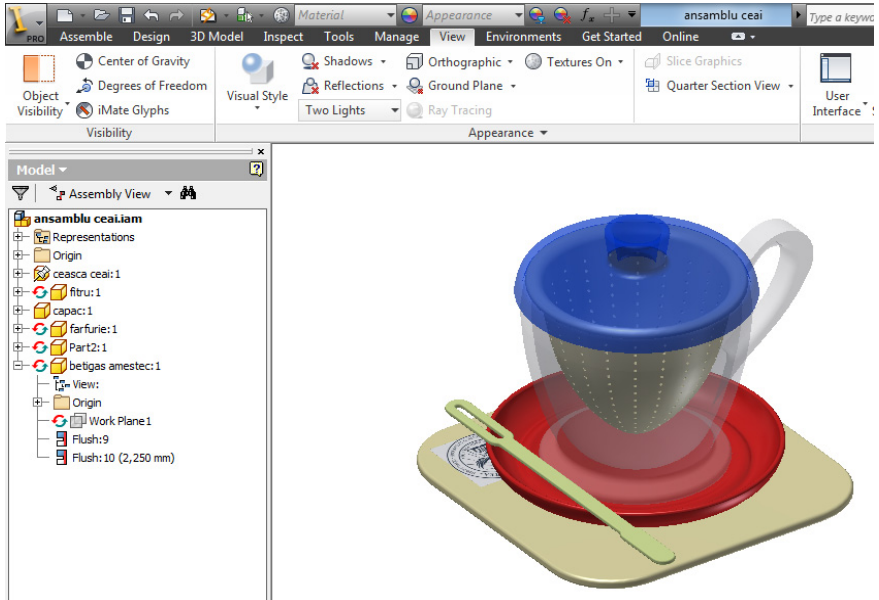
Figure 8. Set toy for children—teacup.